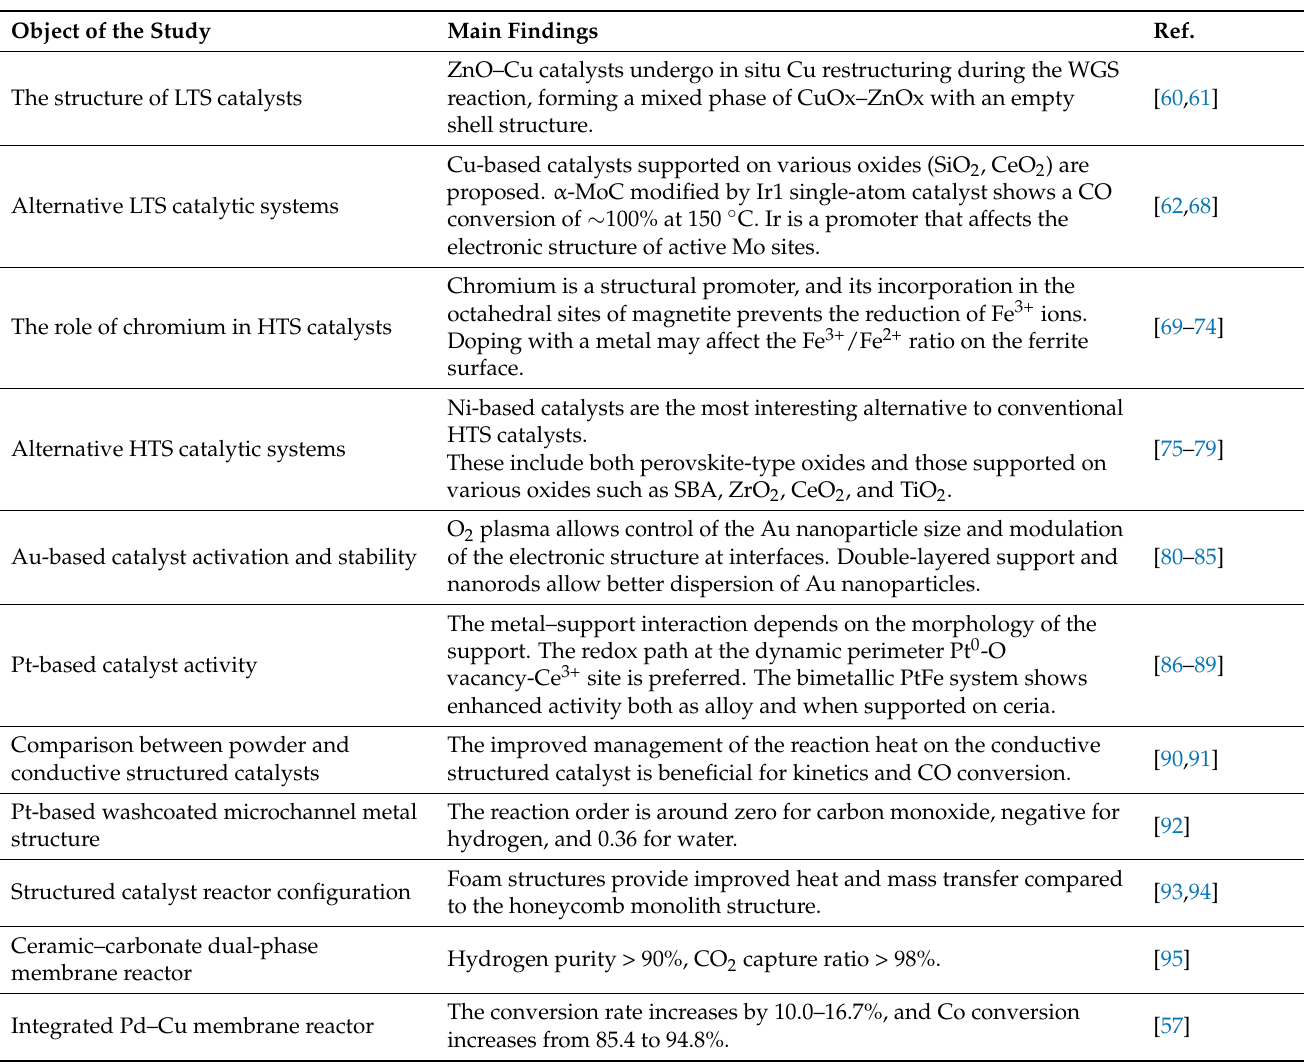
Table 4. Schematic summary of the main findings resulting from the reviewed articles of the WGS